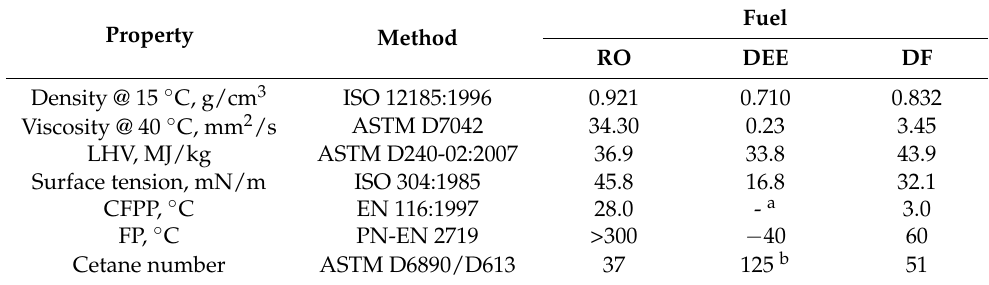
Table 3. Selected physicochemical properties of tested fuels. Developed from [15,42]. Property Method